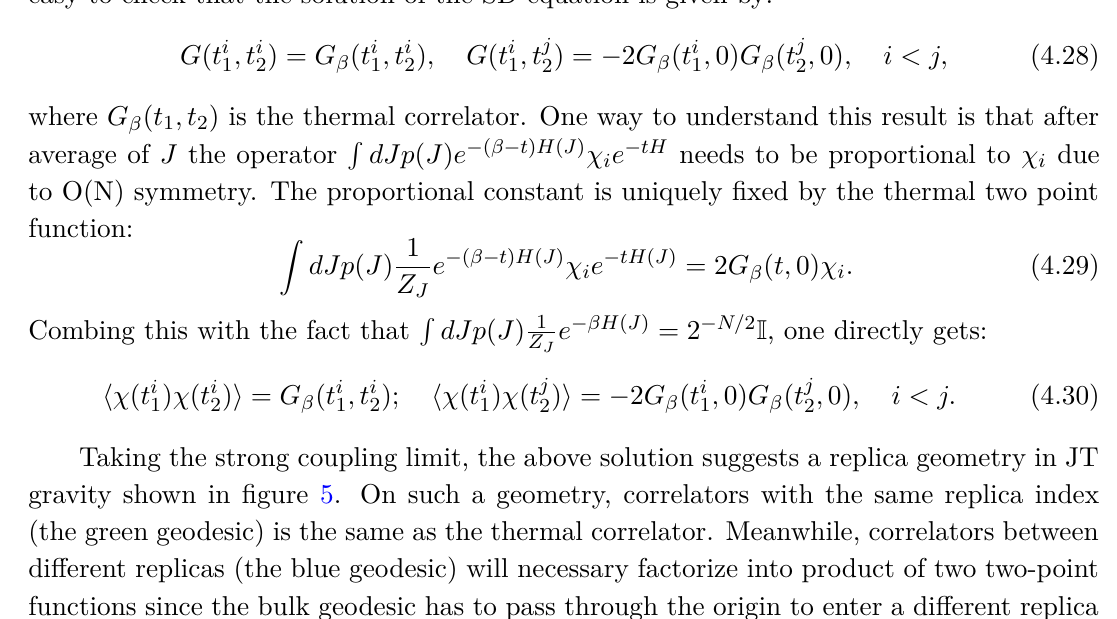
(cid:0) (cid:1) t i , t i and the across-replica two-point 1 2